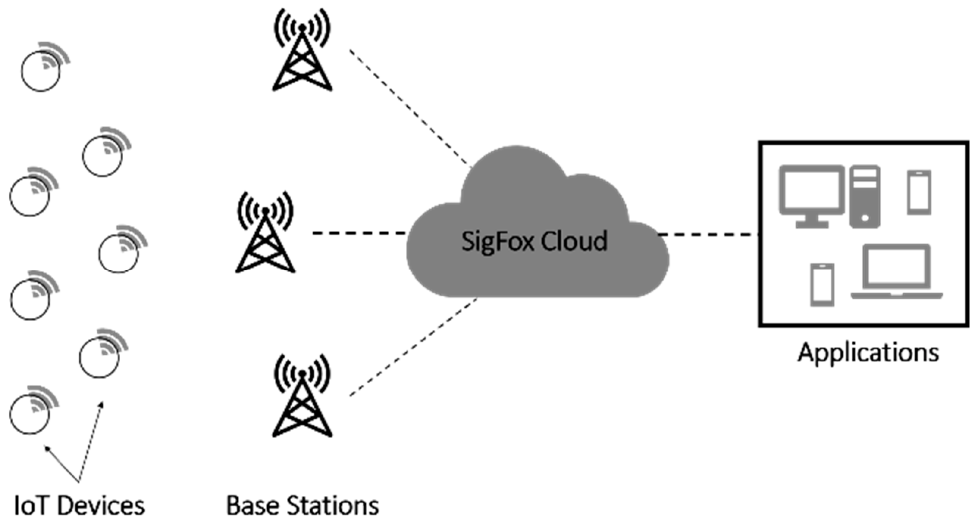
Figure 1. SigFox Figure 1. SigFox components.